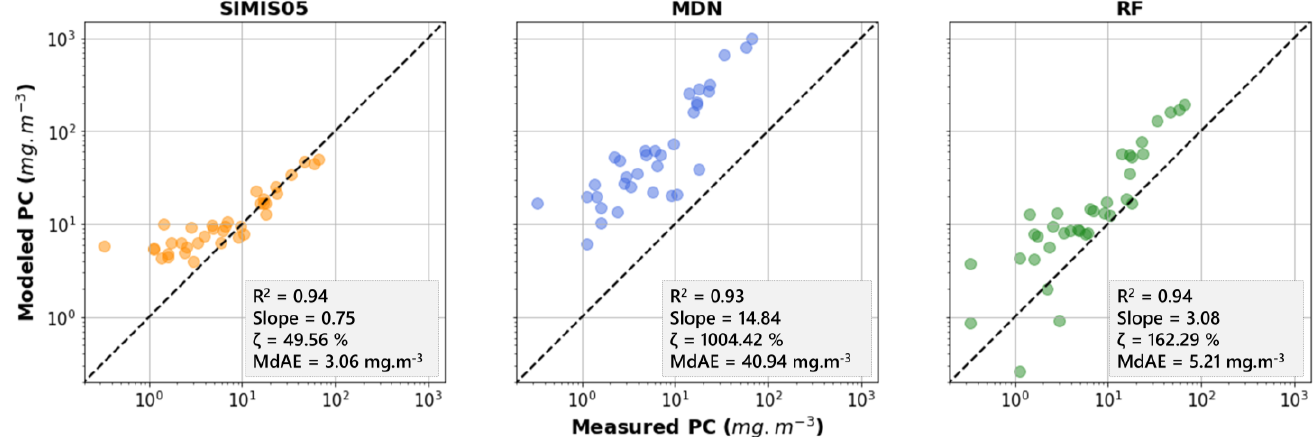
Figure 6. Performance assessment of semi-analytical (Simis et al. (2005)) and machine learning al- gorithms (MDN and RF) using in situ measured PC for 3 – 10 October 2021. Reported metrics are algorithms (MDN and RF) using in situ measured PC for 3–10 October 2021. Reported metrics median symmetric accuracy (ζ), slope, regression coefficient (R 2 ), and the median absolute error are median symmetric accuracy ( ζ ), slope, regression coefficient (R 2 ), and the median absolute (MdAE). error